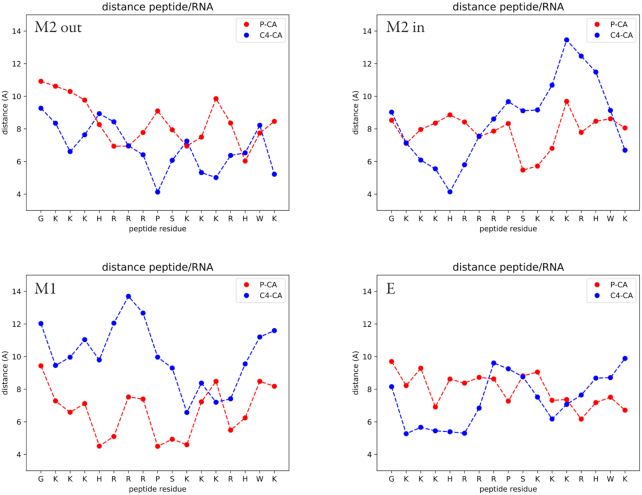
Average distances of the residues of the ARM peptide from the RNA as measured from the CA atom of the amino acid to either the closest phosphate atom (P), indicating the distance of the amino acid to the RNA backbone, or the closest C4 atom, indicating the distance of the amino acid to the RNA bases. Averages are performed on the MD trajectories for the 4 systems.